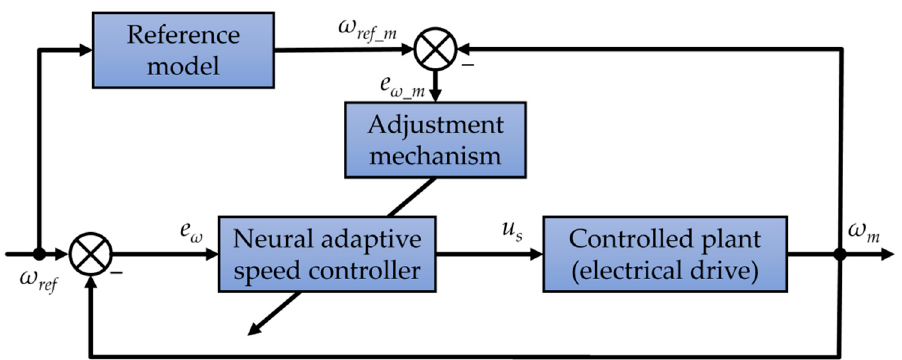
Figure 8. Neural adaptive control structure with reference model.